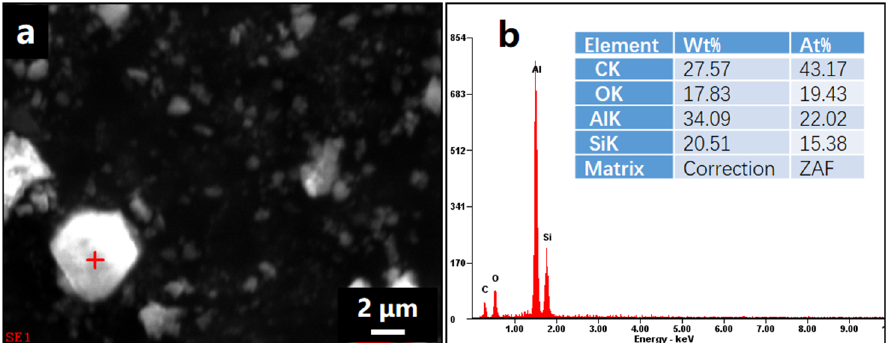
Figure 9. ( a , b ) The EDS analysis result of wear debris at 300 °C, the red plus sign in Figure 9a is the EDS sampling point. sampling